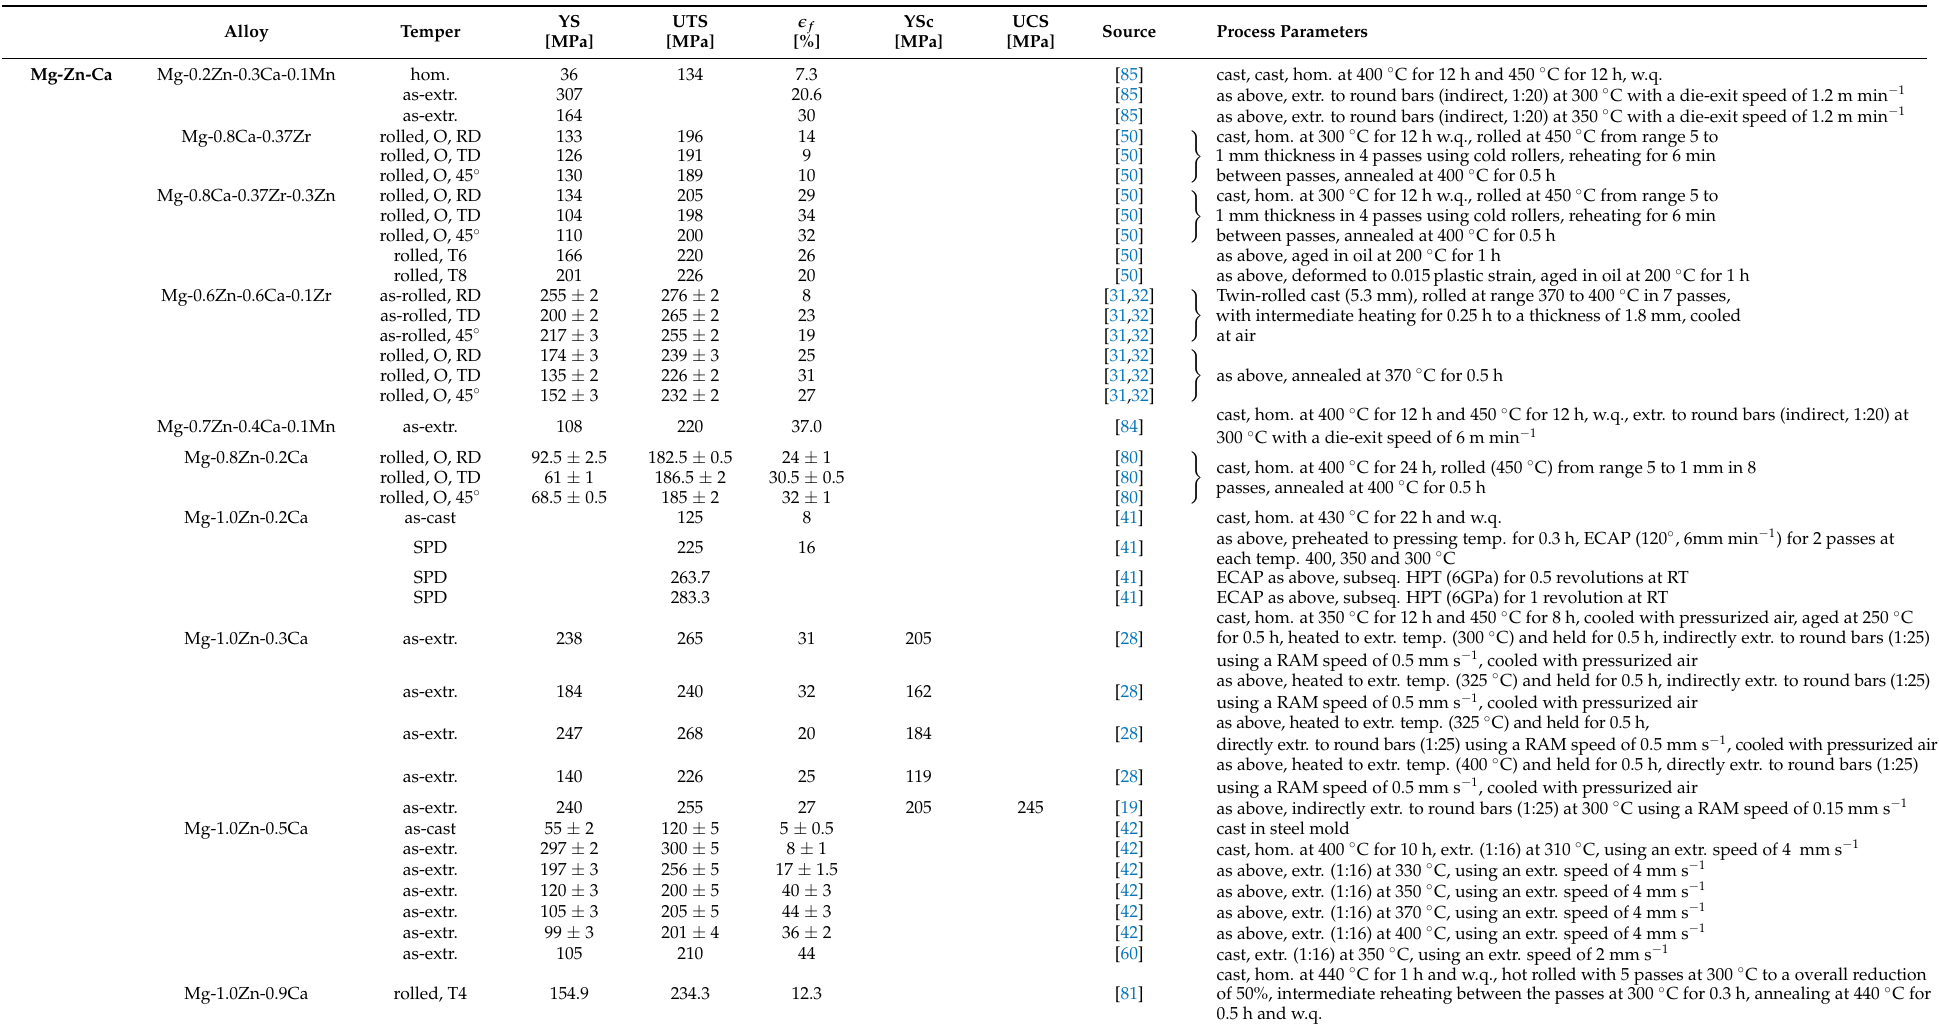
Alloy Temper Mg-Zn-Ca Mg-0.2Zn-0.3Ca-0.1Mn hom. [85] cast, cast, hom. at 400 ◦ C for 12 h and 450 ◦ C for 12 h, w.q. as-extr. 307 20.6 [85] as above, extr. to round bars (indirect, 1:20) at 300 ◦ C with a die-exit speed of 1.2 m min − 1 as-extr. 164 30 [85] as above, extr. to round bars (indirect, 1:20) at 350 ◦ C with a die-exit speed of 1.2 m min − 1 Mg-0.8Ca-0.37Zr rolled, O, RD [50] (cid:41) cast, hom. at 300 ◦ C for 12 h w.q., rolled at 450 ◦ C from range 5 to 1 mm thickness in 4 passes using cold rollers, reheating for 6 min hrolled, O, TD between passes, annealed at 400 ◦ C for 0.5 as above, aged in oil at 200 ◦ C for 1 h rolled, T8 as above, deformed to 0.015plastic strain, aged in oil at 200 ◦ C for 1 h Mg-0.6Zn-0.6Ca-0.1Zr [31,32] (cid:41) Twin-rolled cast (5.3 mm), rolled at range 370 to 400 ◦ C in 7 passes, with intermediate heating for 0.25 h to a thickness of 1.8 mm, cooled (cid:41) as above, annealed at 370 ◦ C for 0.5 hrolled, O, TD cast, hom. at 400 ◦ C for 12 h and 450 ◦ C for 12 h, w.q., extr. to round bars (indirect, 1:20) at Mg-0.7Zn-0.4Ca-0.1Mn as-extr. 108 37.0 [84] 300 ◦ C with a die-exit speed of 6 m min − 1 Mg-0.8Zn-0.2Ca rolled, O, RD [80] (cid:41) cast, hom. at 400 ◦ C for 24 h, rolled (450 ◦ C) from range 5 to 1 mm in 8 passes, annealed at 400 ◦ C for 0.5 hrolled, O, TD [41] cast, hom. at 430 ◦ C for 22 h and w.q. ◦ , 6mm min − 1 ) for 2 passes at SPD 225 16 [41] as above, preheated to pressing temp. for 0.3 h, ECAP (120 each temp. 400, 350 and 300 ◦ C SPD 263.7 [41] ECAP as above, subseq. HPT (6GPa) for 0.5 revolutions at RT SPD 283.3 [41] ECAP as above, subseq. HPT (6GPa) for 1 revolution at RT cast, hom. at 350 ◦ C for 12 h and 450 ◦ C for 8 h, cooled with pressurized air, aged at 250 ◦ C for 0.5 h, heated to extr. temp. (300 ◦ C) and held for 0.5 h, indirectly extr. to round bars (1:25) Mg-1.0Zn-0.3Ca as-extr. 238 265 31 205 [28] using a RAM speed of 0.5 mm s − 1 , cooled with pressurized air as above, heated to extr. temp. (325 ◦ C) and held for 0.5 h, indirectly extr. to round bars (1:25) as-extr. 184 240 32 162 [28] using a RAM speed of 0.5 mm s − 1 , cooled with pressurized air as above, heated to extr. temp. (325 ◦ C) and held for 0.5 h, as-extr. 247 268 184 [28] directly extr. to round bars (1:25) using a RAM speed of 0.5 mm s − 1 , cooled with pressurized air as above, heated to extr. temp. (400 ◦ C) and held for 0.5 h, directly extr. to round bars (1:25) as-extr. 140 226 119 [28] using a RAM speed of 0.5 mm s − 1 , cooled with pressurized air as-extr. 240 255 [19] as above, indirectly extr. to round bars (1:25) at 300 ◦ C using a RAM speed of 0.15 mm s − 1 Mg-1.0Zn-0.5Ca as-cast 55 ± 2 120 ± 5 5 ± 0.5 [42] cast in steel mold as-extr. [42] cast, hom. at 400 ◦ C for 10 h, extr. (1:16) at 310 ◦ C, using an extr. speed of 4 mm s − 1 as-extr. 197 ± 3 as above, extr. (1:16) at 330 ◦ C, using an extr. speed of 4 mm s − 1 as-extr. 120 ± 3 [42] as above, extr. (1:16) at 350 ◦ C, using an extr. speed of 4 mm s − 1